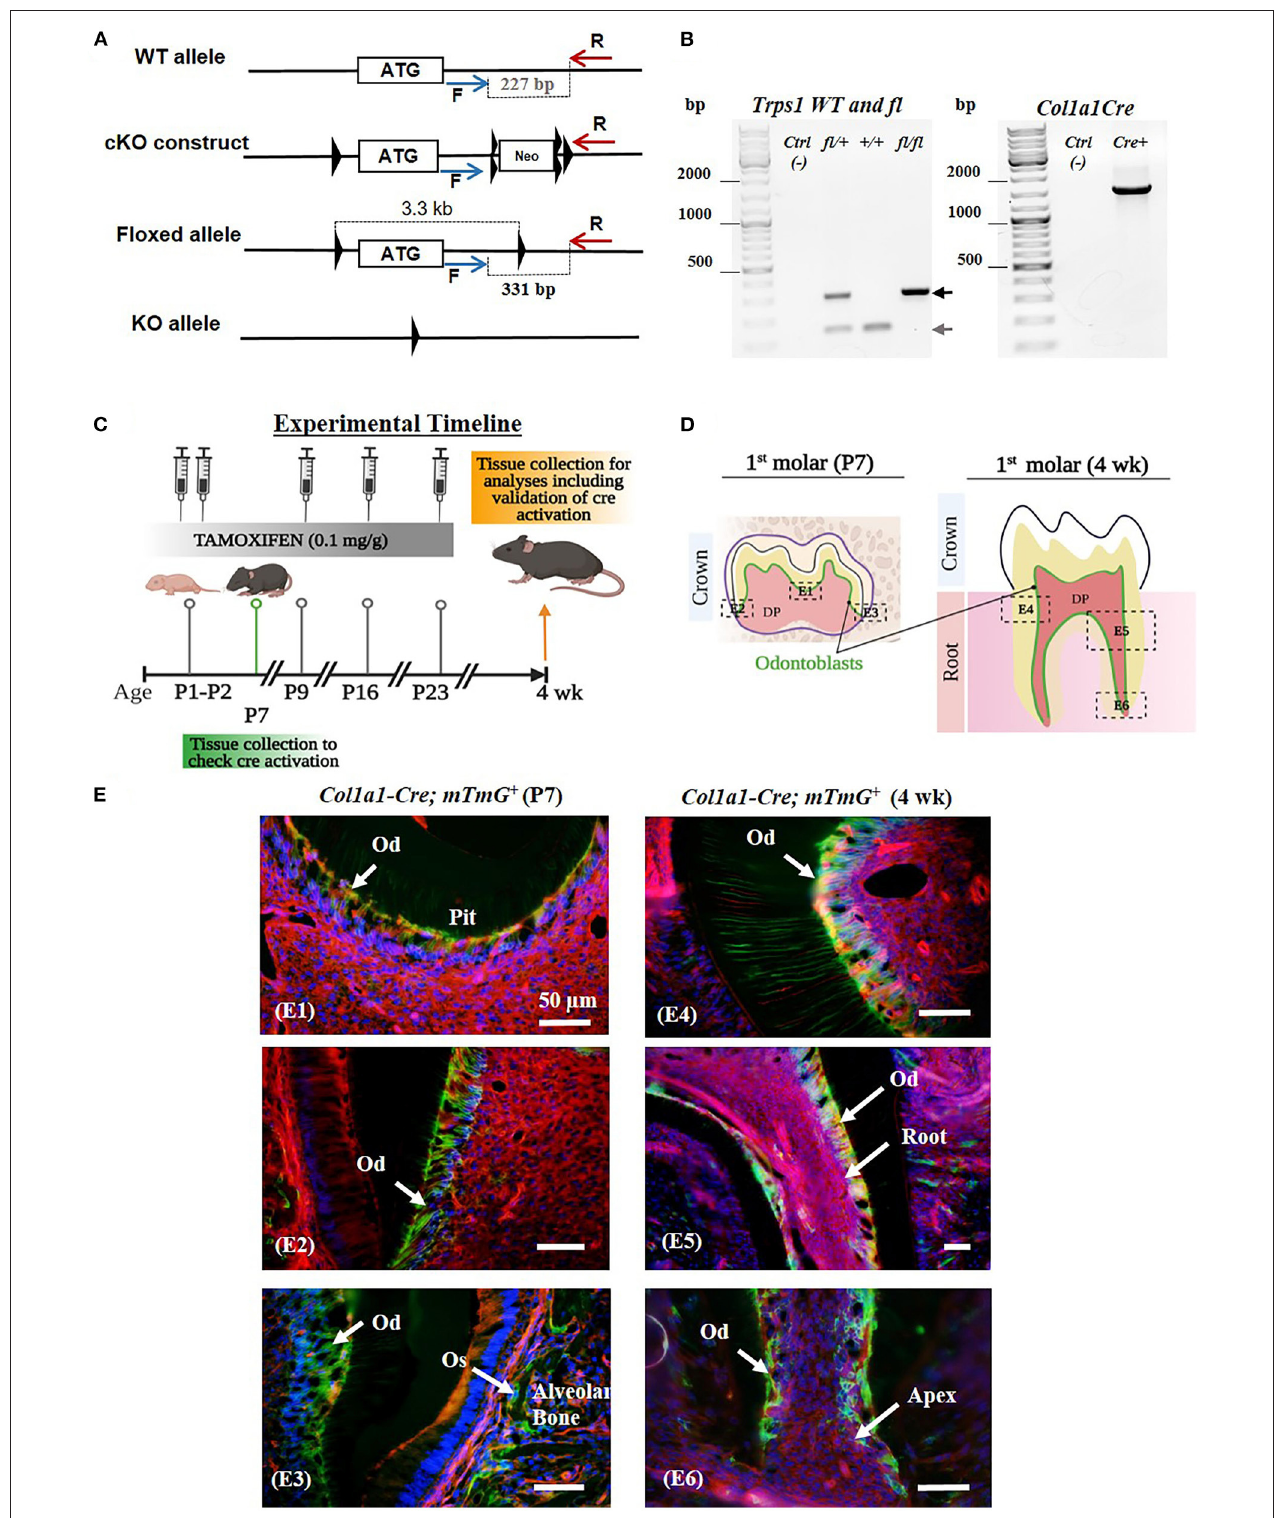
FIGURE 1 | Generation of Trps1 Col1a1 cKO mice and verification of Cre-mediated recombination in odontoblasts. (A) The conditional knockout strategy: schematics of Trps1 WT allele, targeting construct, and floxed allele showing the first coding exon (the white box with the ATG) and relative localization of LoxP sites (triangles),